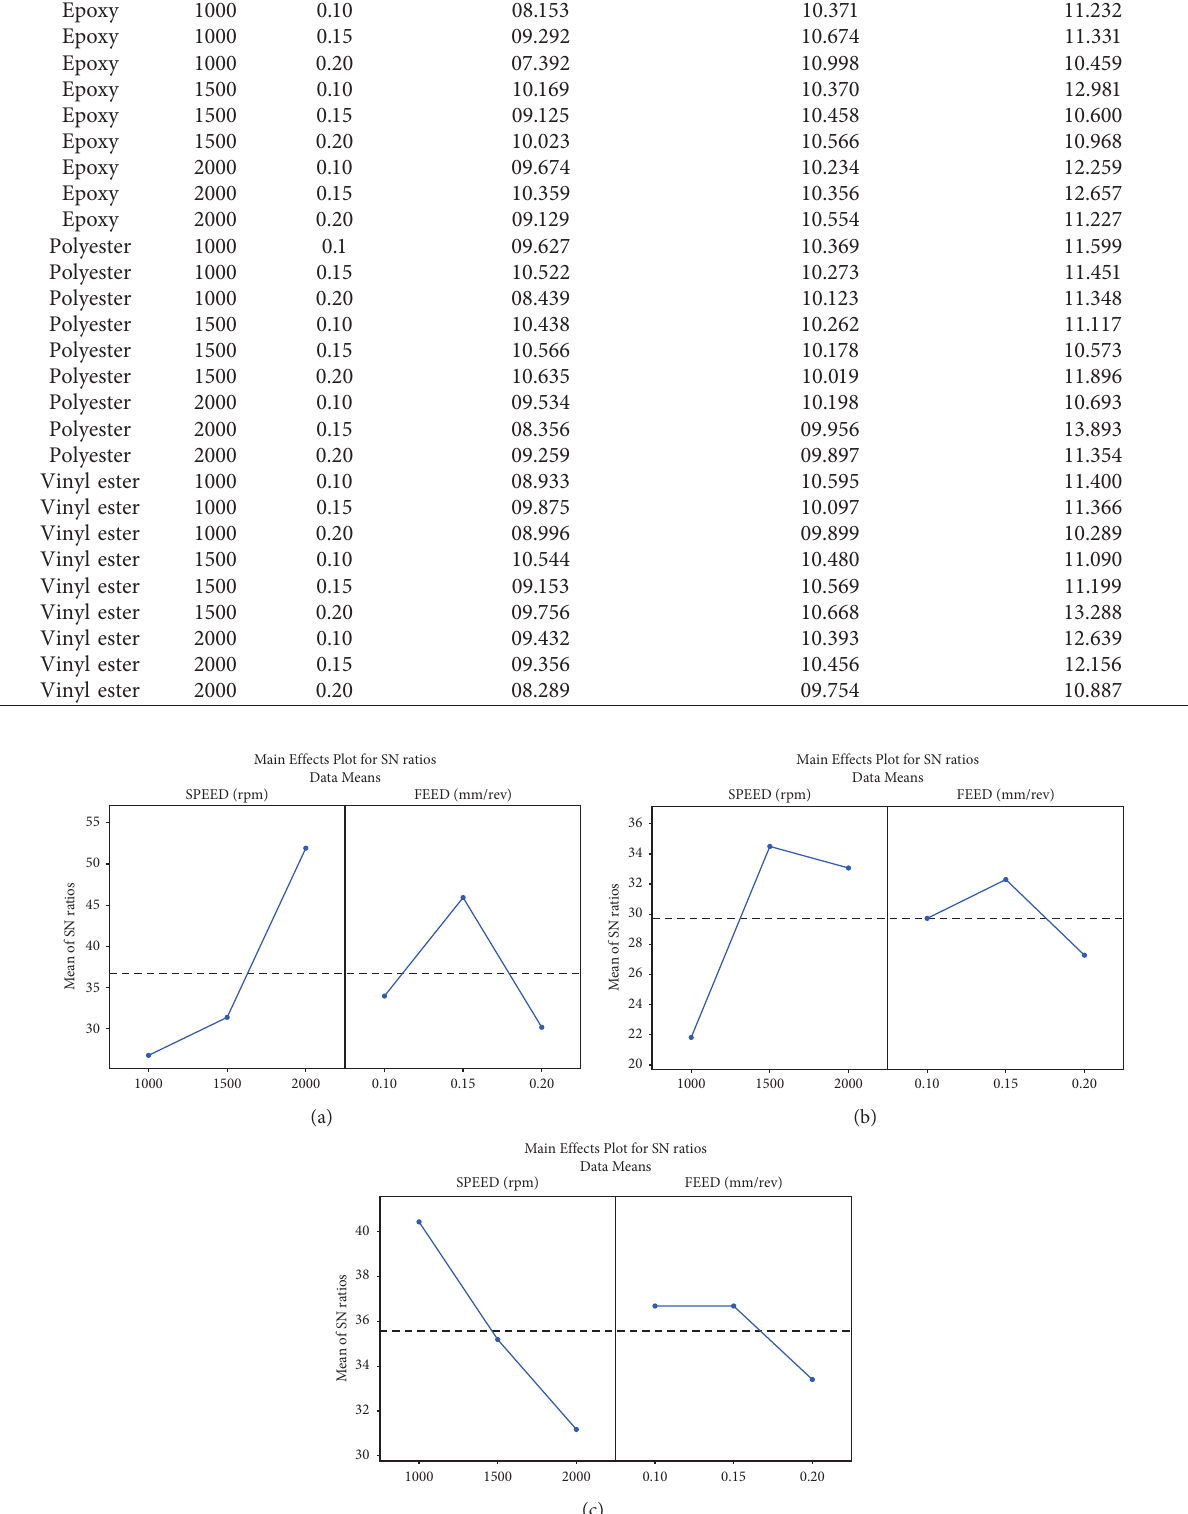
Table 2: Thrust force generated by the candlestick, standard twist, and step cone drill bits during the drilling process. S. no